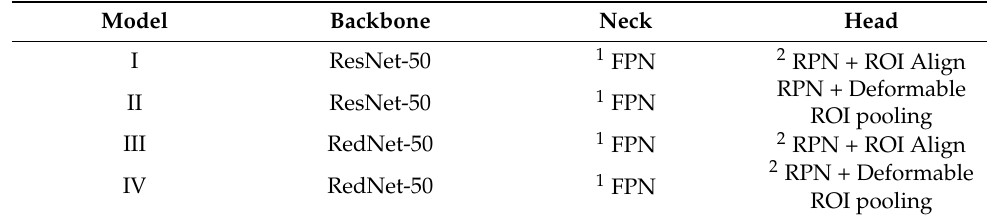
Table 2. Detection models with different module